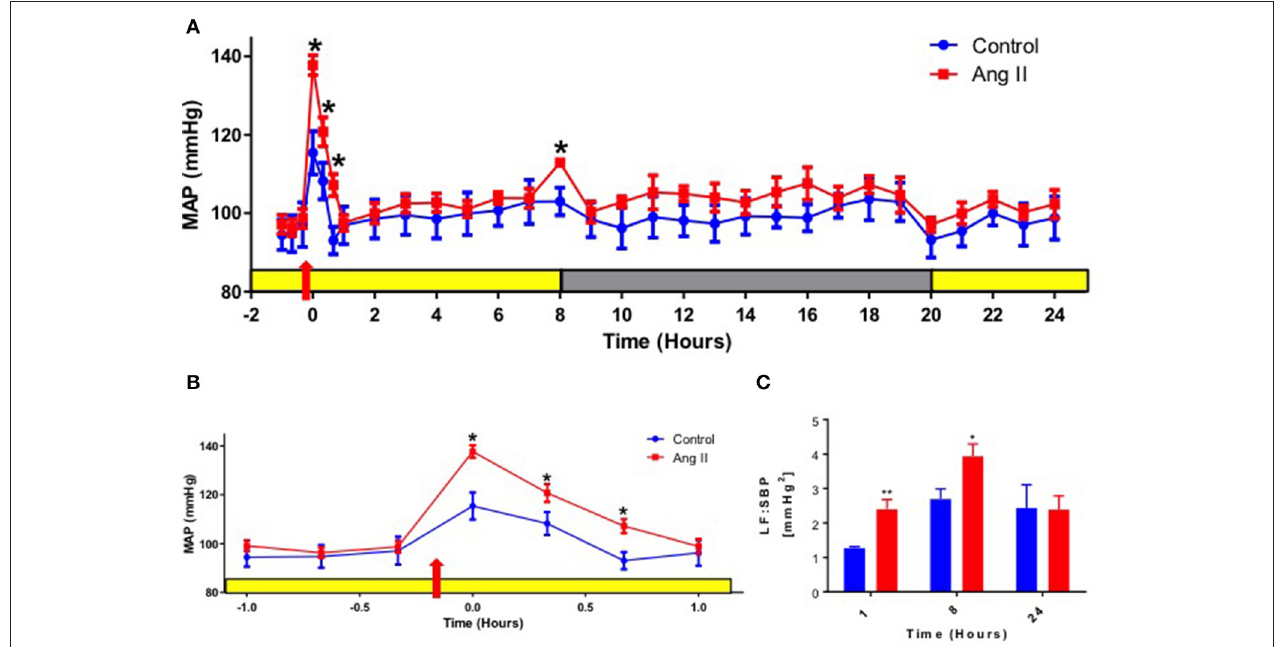
FIGURE 1 | Effects of systemic Ang II injection on blood pressure. (A) Mean arterial pressure (MAP) over 24 h in WKY rats injected with Ang II (red) or control saline I.P. (blue). Yellow bar represents daylight period, and gray represents night time period. Red arrow represents time of Ang II injection, 10 min prior to recording at time zero. (B) A re-plotted diagram of MAP effects highlighting 1 h prior and post-Ang II (red) or control saline injection (blue). (C) Power spectral analysis of systolic blood pressure (SBP) signal at 1,8 and 24h post Ang II injection (red bars) vs. control saline-injected WKY at the equivalent time points (blue bars). ± SEM. N = 6 per group. Unpaired Student T test was used in B and C. * p < 0.05 vs. control, ** p < 0.01 vs.